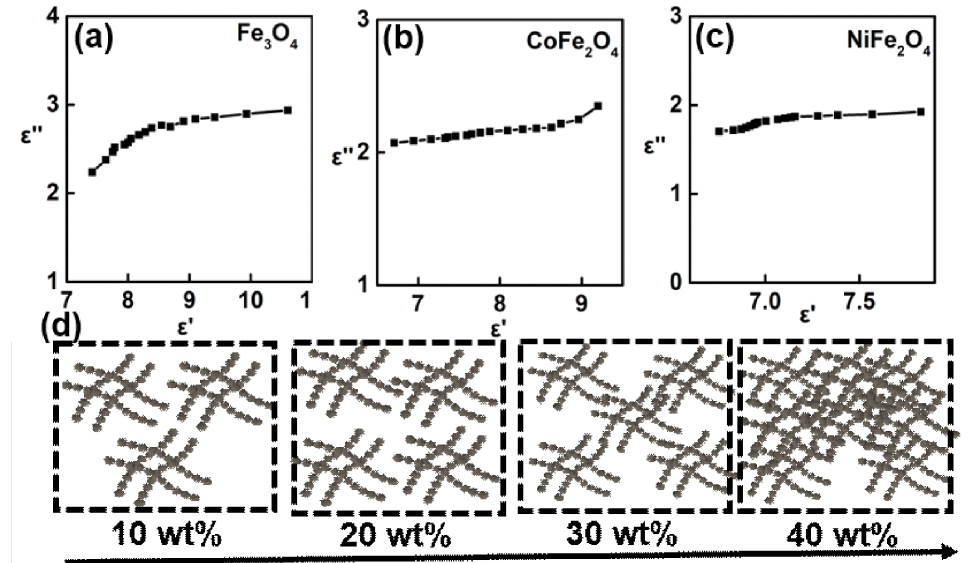
Figure 5. ( a – c ) Cole-Cole curves for the 30 wt%-ferrite-paraffin wax composite; ( d ) schematic illus- tration of the relationship between weight ratios and conductive loss. tion of the relationship between weight ratios and conductive